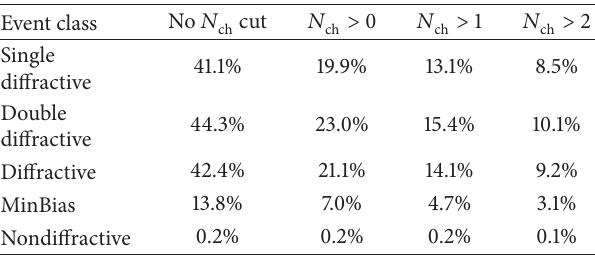
Table 8: The fraction of DDD events which have at least one neutral particleinZDC 󸀠󸀠 (theZDCdetectoronthesidewiththegap)isgiven for different cuts on the size of Δ𝜂 and with different thresholds for thetransversemomentumoftheneutralparticles.Thegapisdefined as an edge gap and the final state particles within |𝜂| < 5.2 with 𝑝 T > 200 MeV are used to find the size of the gap.